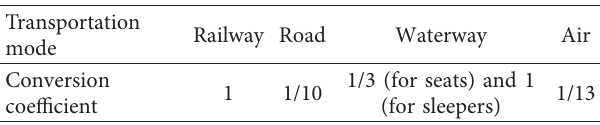
Table 2: Conversion coefficients used in comprehensive concerted